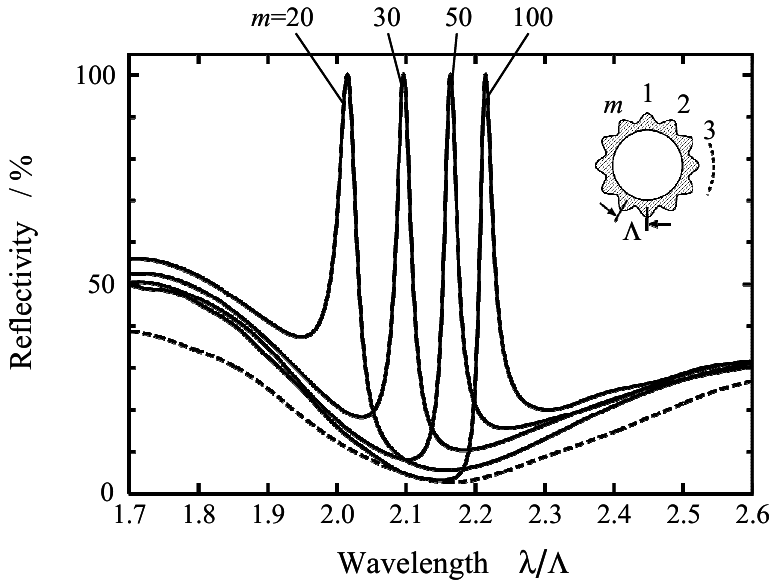
Figure 3. Reflection spectra viewed from inside the curved grating. “ m ” is the number of gratings on the outer edge of the cavity wall. The broken line shows the spectrum of the average index structure of Figure 2(b) for m =